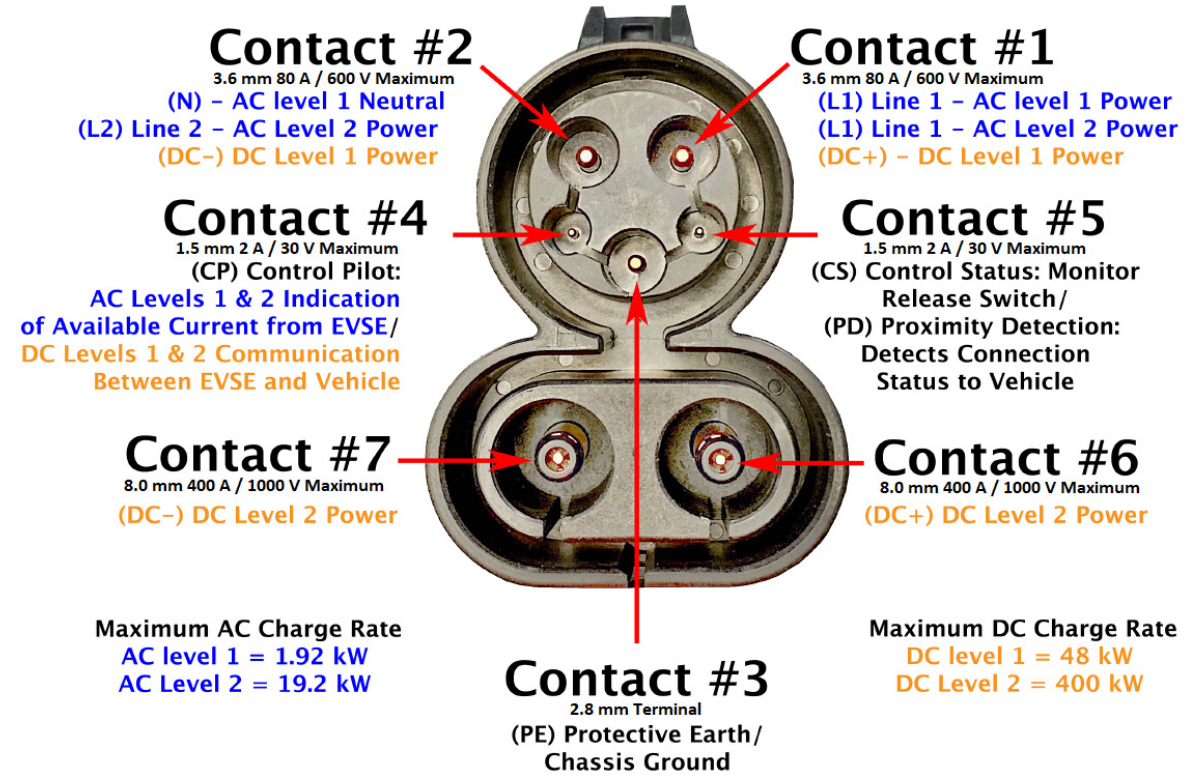
Figure 15. The pinout of the CCS Combo 1 EV inlet.